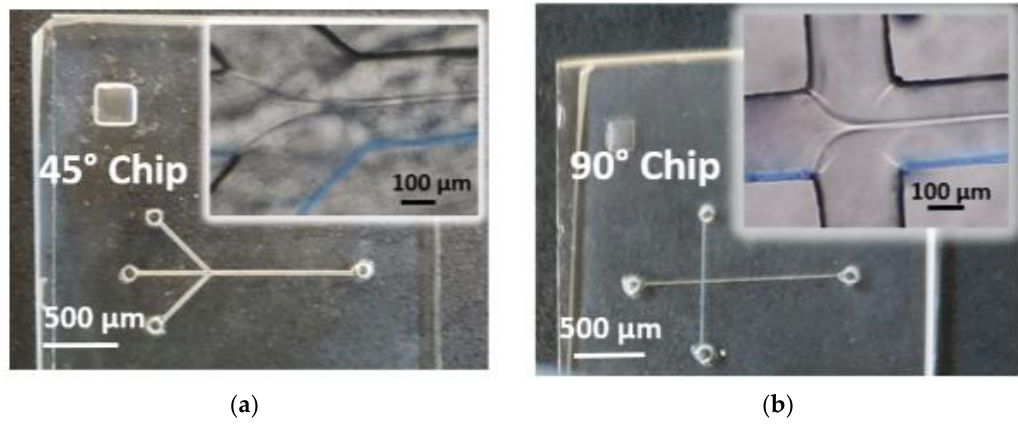
Figure 1. Images of ( a ) 45° chips and ( b ) 90° chips with zoomed images in the focusing regions shown in the insets. The ethanol laminas formed at Flow-Rate-Ratios FRR = 10 and total volumetric flow rate Q t = 105 μL/min in the 45° chip, and FRR = 2, and Q t = 90 μL/min in the 90° chip. Five chips labelled as “S” (with h ≈ 25 μm) and “M” (with h ≈ 50 μm) were tested at a low lipid